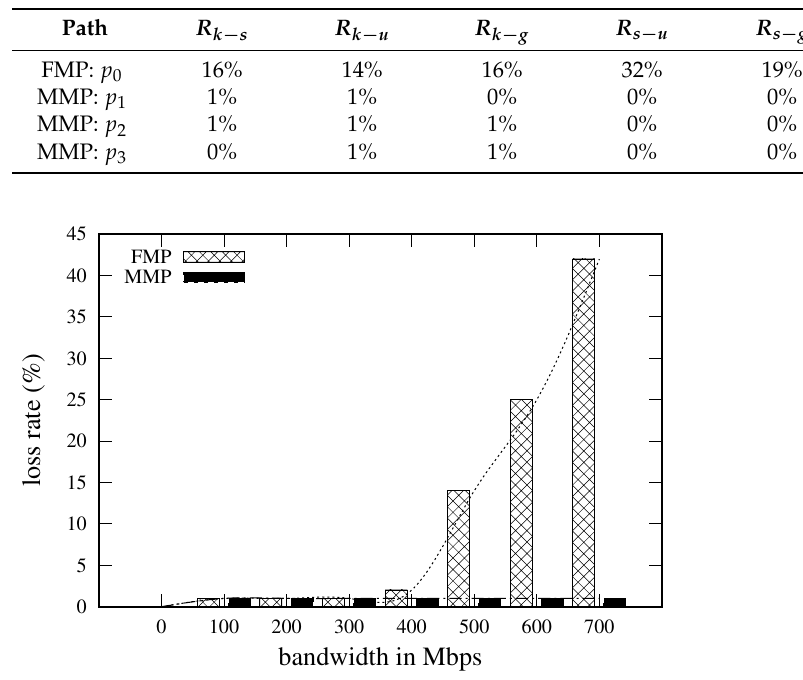
Figure 9. Effect of traffic on FMP. The loss rate is dramatically increased by the traffic congestion on FMP, but MMP manages the path to mitigate the